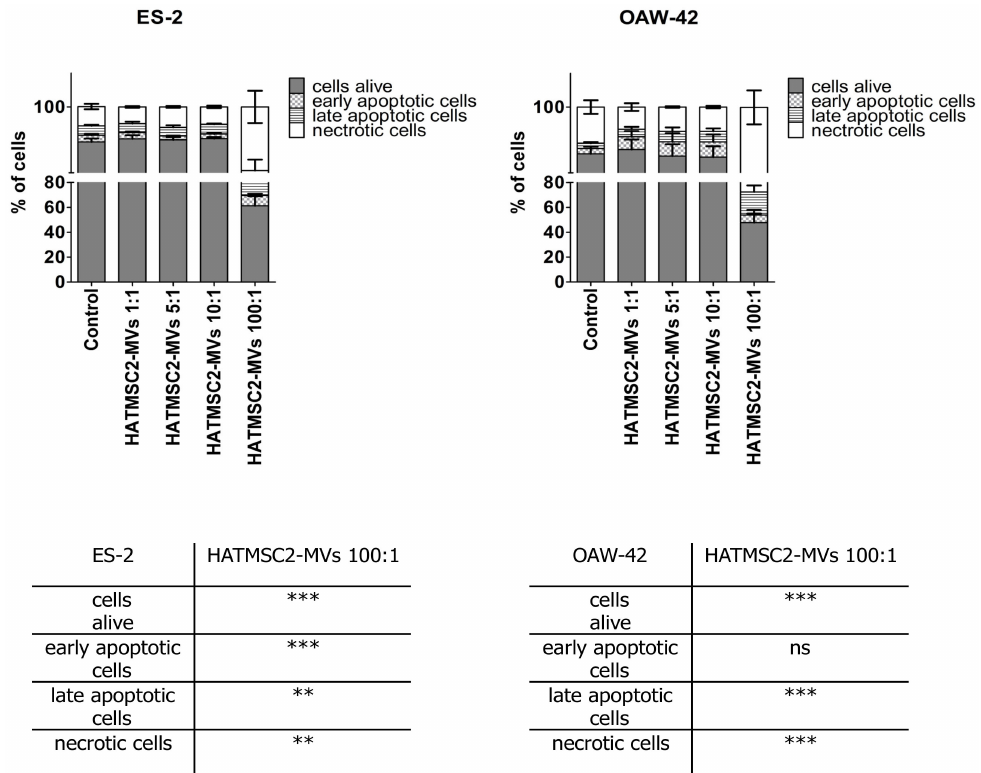
Figure 6. Quantification of cell viability after treatment with HATMSC2-MVs for 72 h at di ff erent ratios, determined using flow cytometric analysis of the apoptotic and necrotic cells via the double-staining of ES-2 and OAW-42 cells with propidium iodide and Annexin V. The percentages of alive, early apoptotic, late apoptotic, and necrotic cells were determined using Flowing Software 2. The data represent mean ± SEM values from five independent experiments performed in duplicate. *** p < 0.001, ** p < 0.01 calculated vs. control, ns: non-significant results. HATMSC2-MVs—microvesicles derived from immortalized human mesenchymal stem cells of adipose tissue